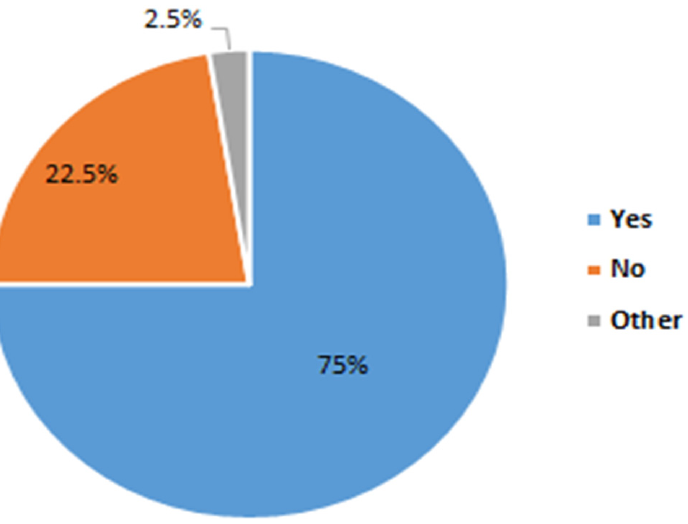
Figure 6. Respondents’ willingness to use V2G if they derived economic benefit from doing so.